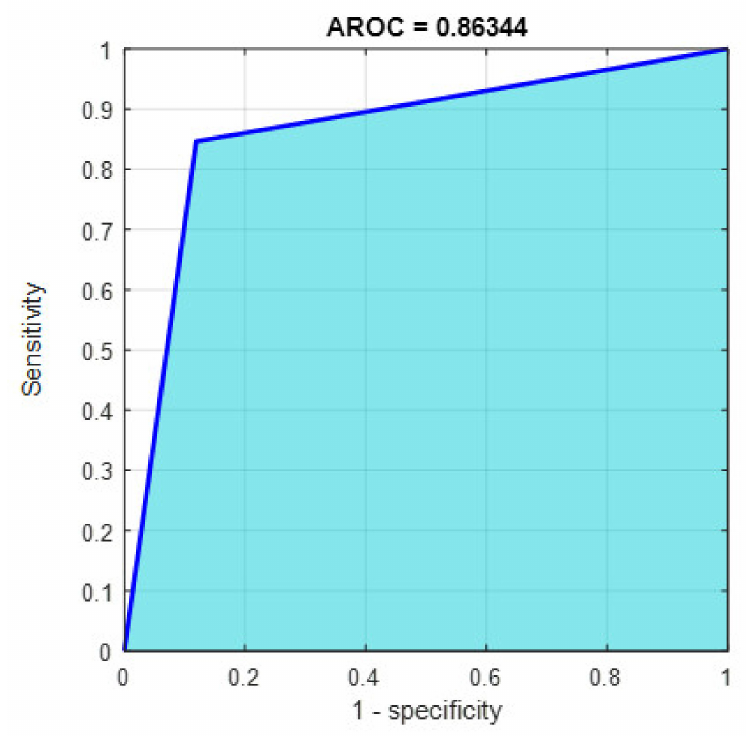
Figure 23. The AROC for Model 1 using 1000 deep learning features.